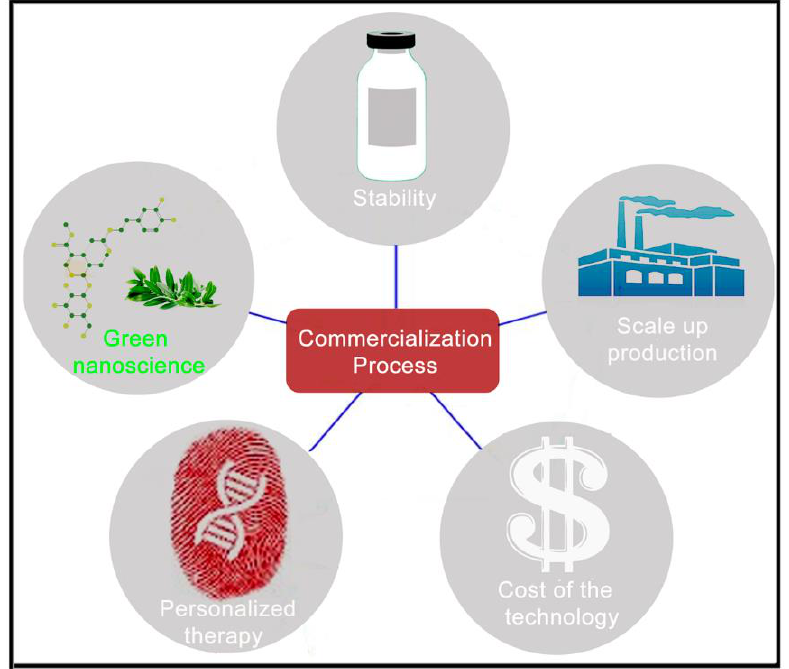
Figure 9. Schematic representation of relevant issues to consider across the commercialization way of non-viral vectors in gene therapy medical field.